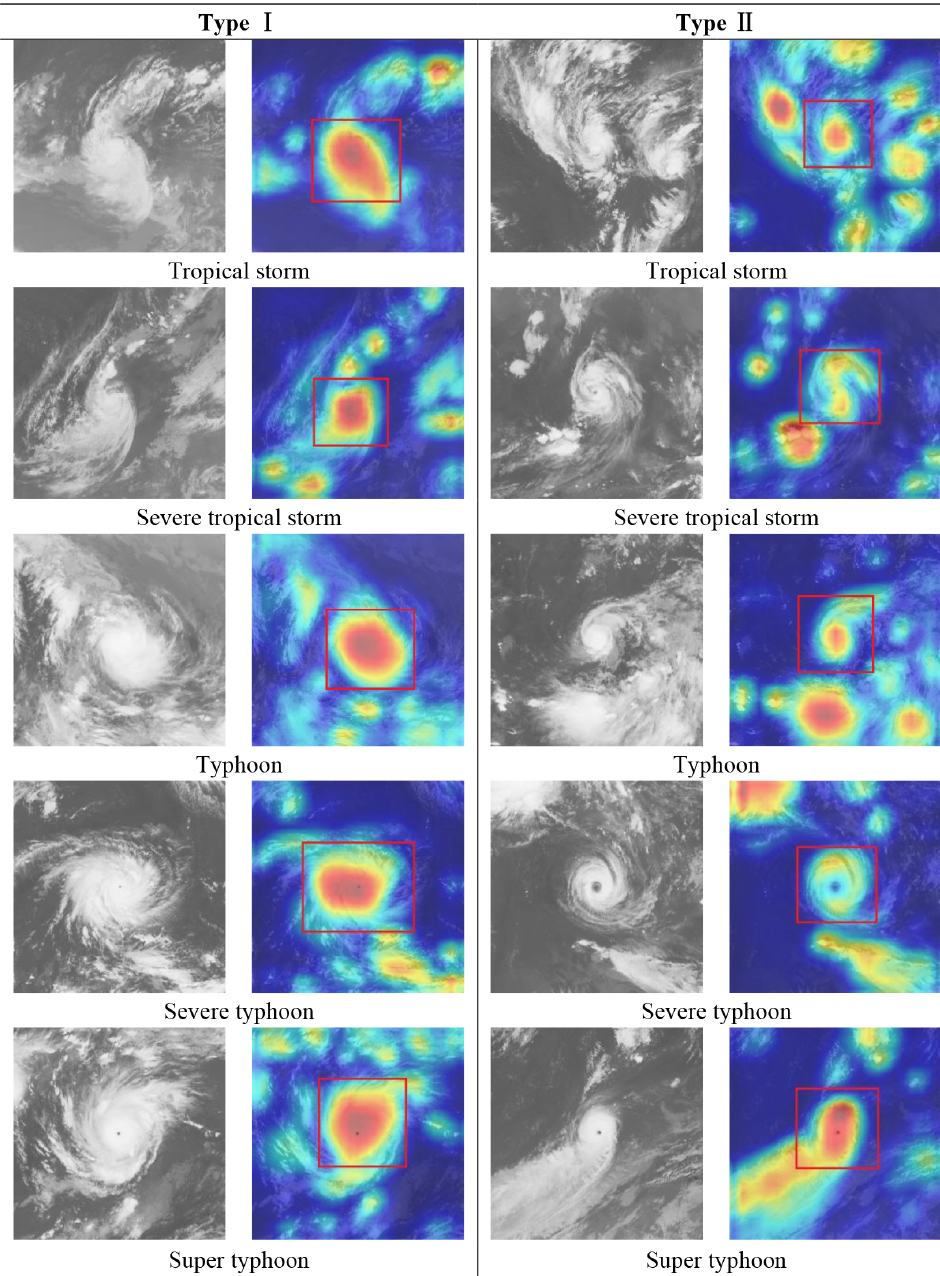
Figure 10. Heat maps (color pictures; TC is demarcated by a red rectangle hereafter) of some successfully identified TC images compared with the associated L images (gray pictures